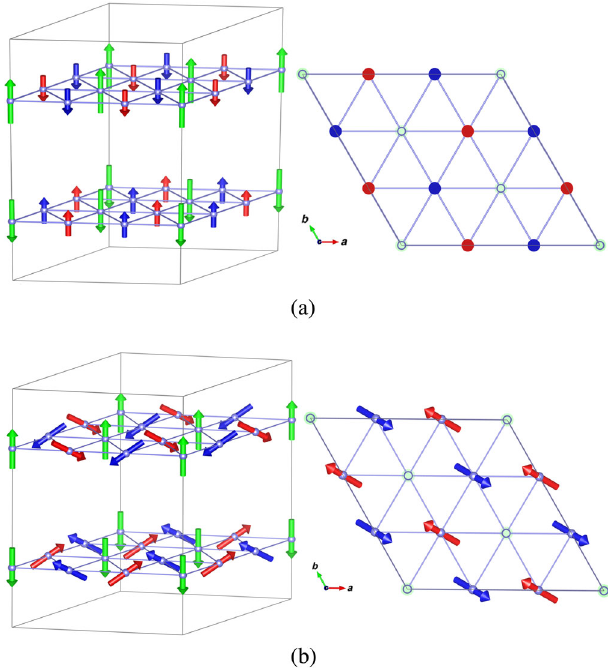
FIG. 10. (a) Three-sublattice static magnetic order of Mn2 atoms (inside the triangular layer) in the intermediate temperature 2 . 2 K ≤ T ≤ 3 K. The magnetic moments are aligned parallel to the c axis in an up-up-down configuration. The moment ampli- ¼ m ℜ ½ cos ð 2 π k · r Þ(cid:2) , ; 1 ; 0 Þ modulation, m tude follows the k ¼ð 1 0 3 3 i i resulting in a fully compensated magnetization inside the plane. Successive triangular layers are stacked in an antiparallel manner. The honeycomb layers maintain the AFM structure shown in Fig. 8 but are omitted for clarity. A view along the c axis of a three-sublattice collinear magnetic order is shown in the right panel. (b) Three-sublattice magnetic structure below 2.2 K. Two of Mn2 atoms develop in-plane ( ab ordered) spin components to form a planar canted Y -type structure, where moments are rotated by about 120° between neighboring sites. The structure remains bilayer with the moments of adjacent layers being antiparallel to each other. The right panel of the figure displays the projection of the spin structure on the ab basal plane.